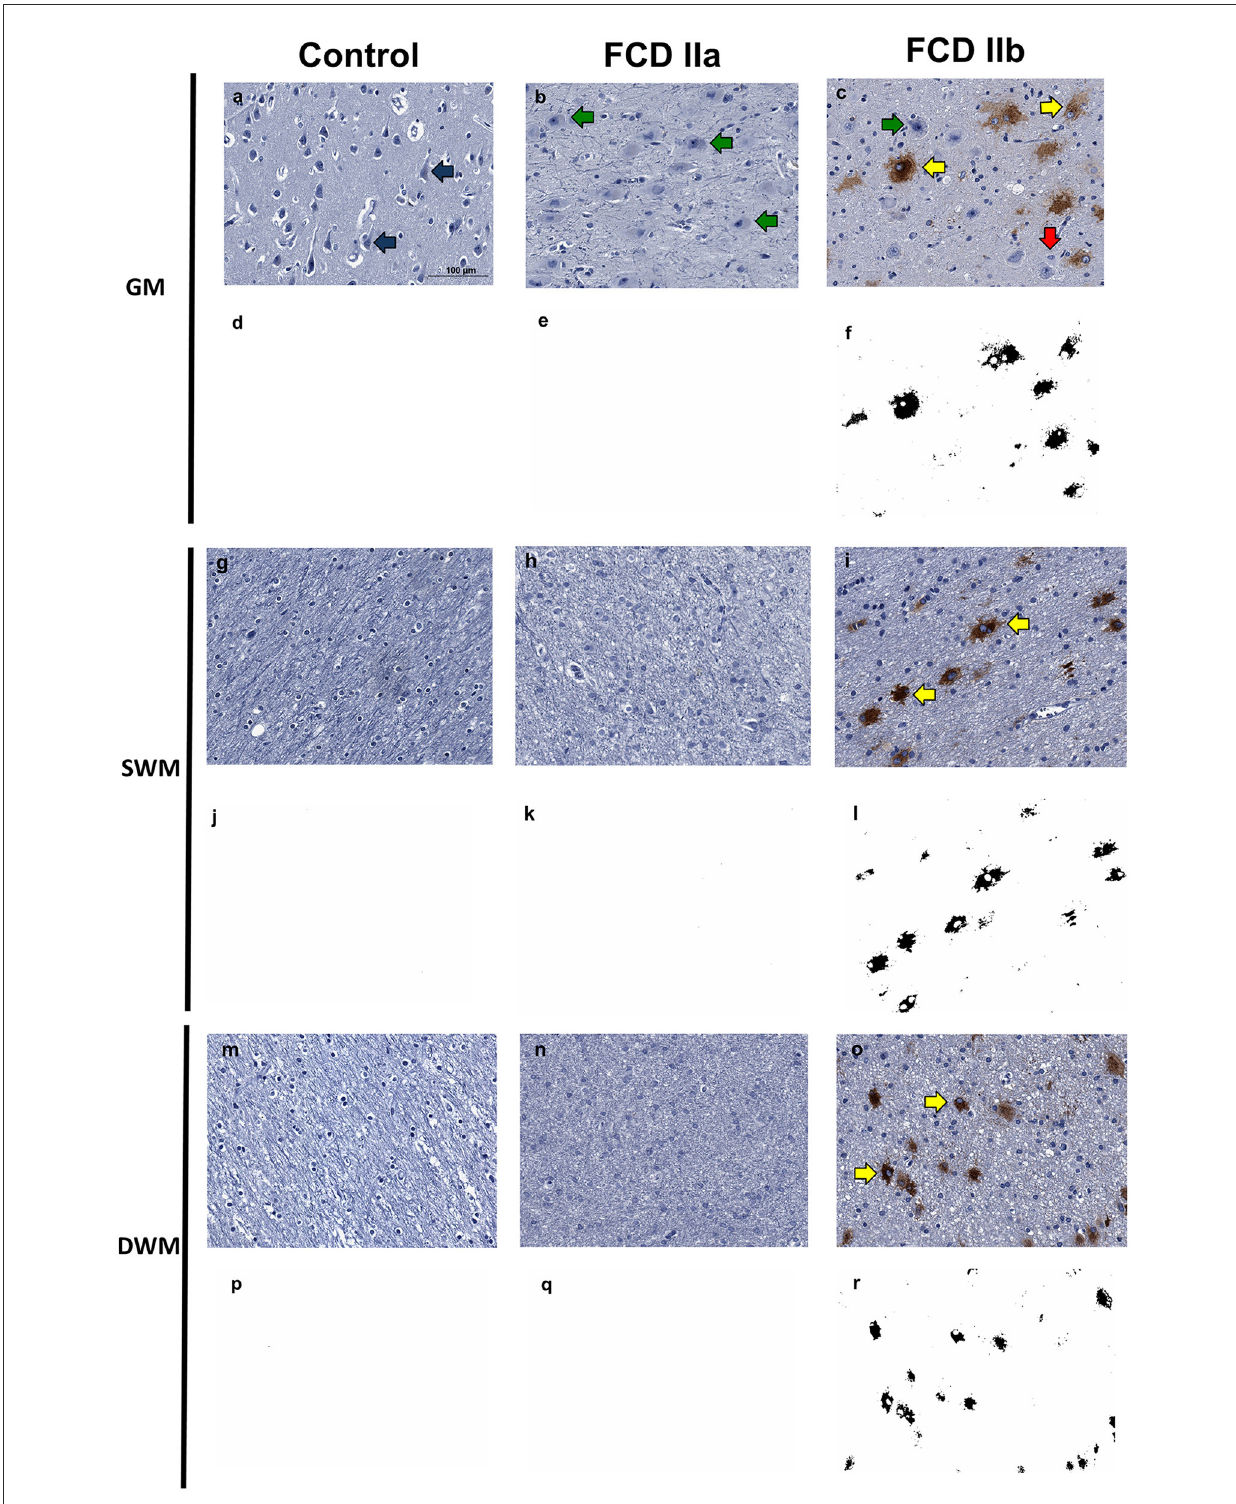
FIGURE8 Immunohistochemical reaction for GPNMB in control, focal cortical dysplasia (FCD) ILAE Type IIa (FCD IIa) and FCD ILAE Type IIb (FCD IIb) specimens. The gray matter (GM), superficial white matter (SWM) and deep white matter (DWM) are shown in (a–f, g–l, m–r) , respectively. Immunopositivity was noted virtually only in balloon cells. Particularly, the staining in such cells varied from null [red arrows in (c) ] to intense [yellow arrows in (c, i, o) ]. Both dysmorphic [green arrows in (b, c) ] and normal [blue arrows in (a) ] neurons were negative. Digital images of the presented immunohistochemical reactions were obtained by using the ImageJ ® software (d–f, j–l, p–r) . In this setting, (d–f, j–l, p–r) correspond to the images shown in (a–c, g–i, m–o) , respectively, after deconvolution and threshold steps. Note that the original immunohistochemical findings (stained structures and tissue distribution) were preserved. Scale bar: 100 µ m (a–r)